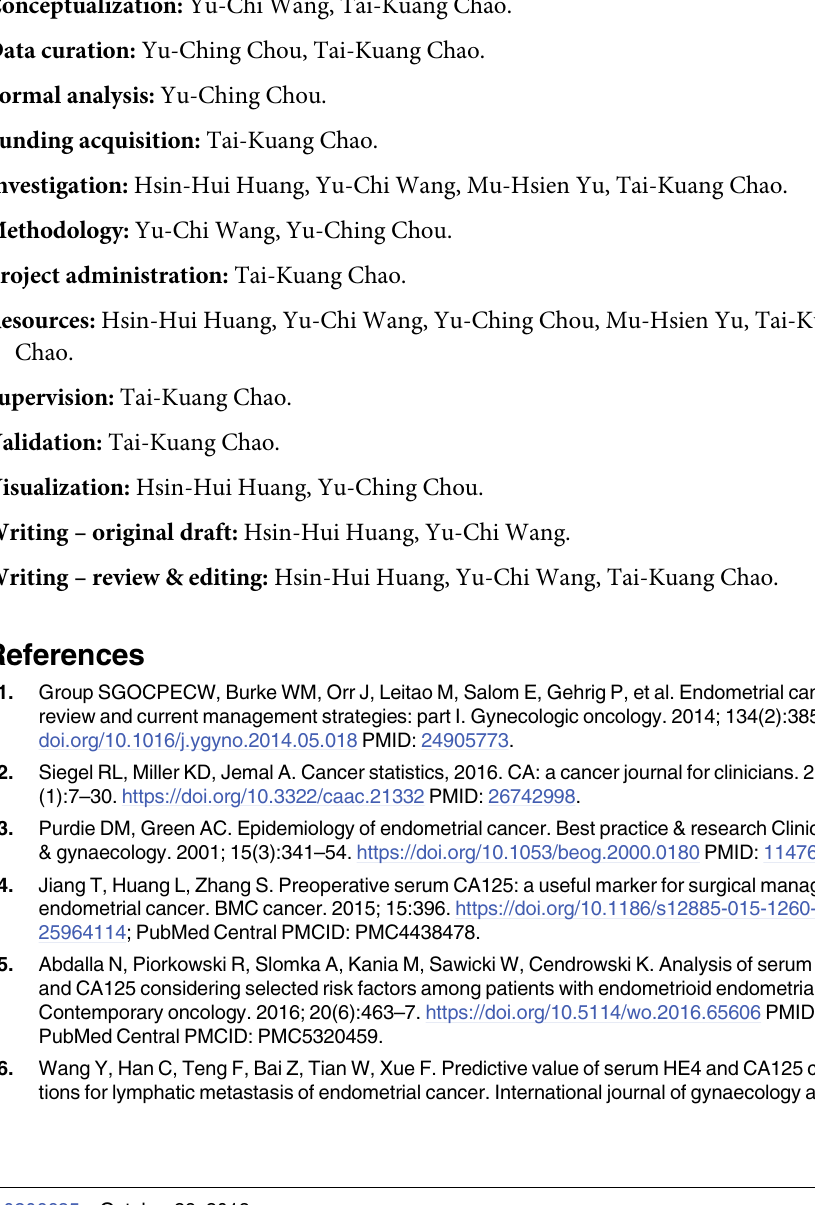
S1 Table. Correlation of ALDH1 in endometrial stroma cells between pre-malignant endo- metrial lesions and endometrial